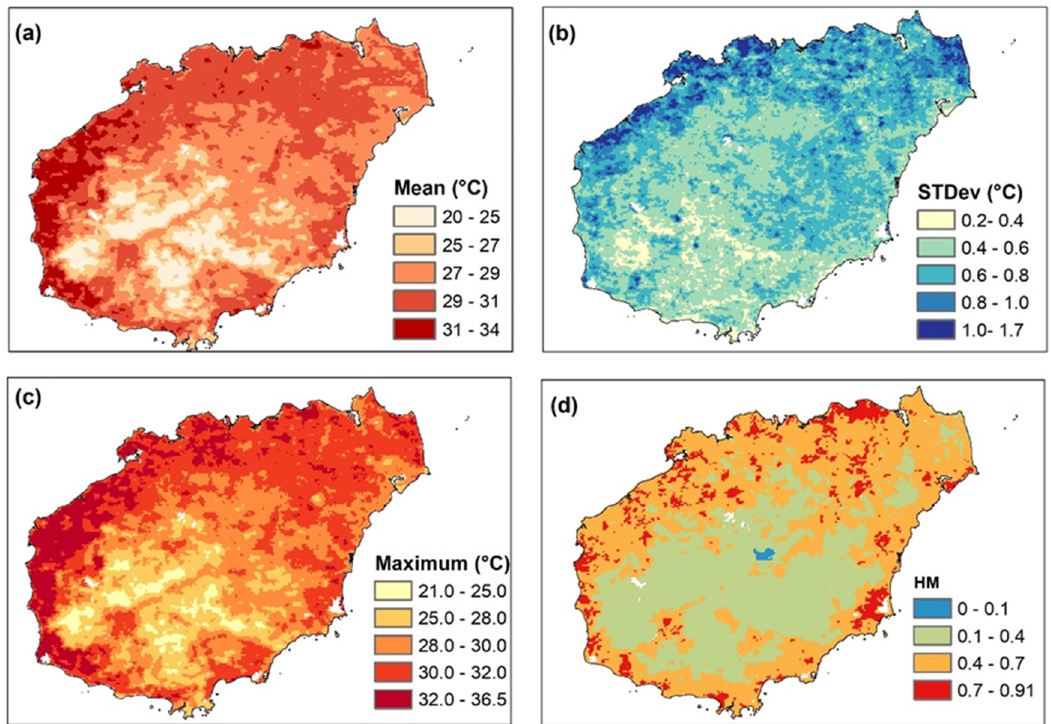
Figure 5. Comparison of mean ( a ), standard deviation ( b ), and maximum temperature ( c ) from 17 yearly data against the human modification data ( d ).